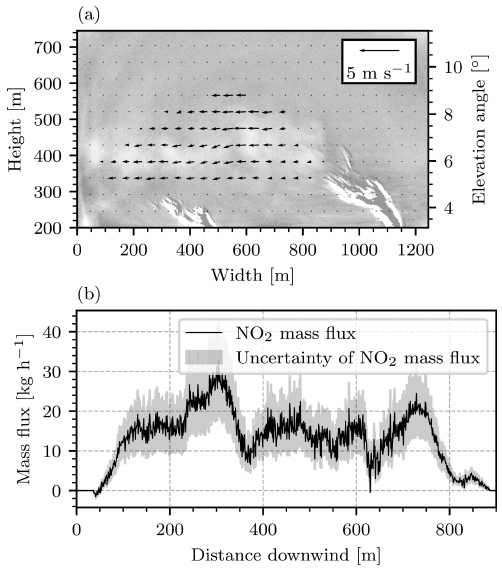
Figure 17. (a) Wind speeds determined from the camera image in Fig. 14 and its successor by application of the Farnebäck algorithm. The wind field is displayed as a vector field in the plume region. (b) NO 2 mass flux obtained from the camera image shown in Fig. 14 and the wind field shown in (a) . The mass flux was plotted against the distance downwind, measured from the point at which the fully condensed part of the plume ends (at a width of 840m in a